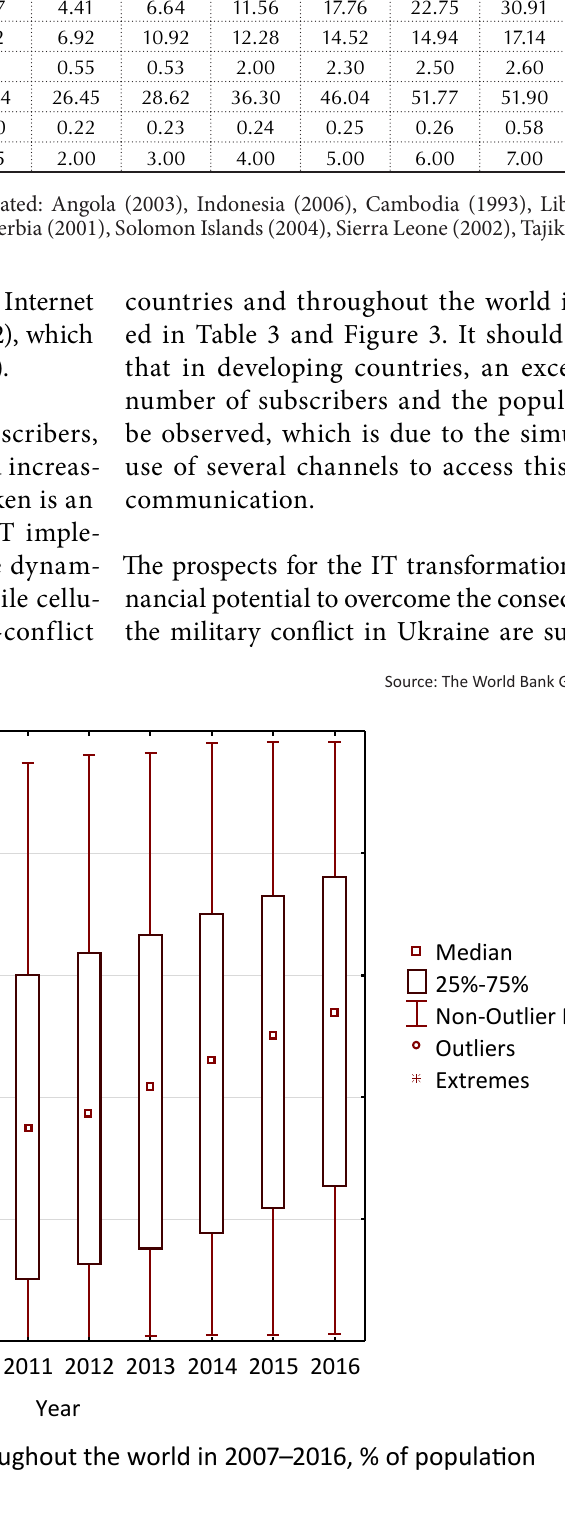
Figure 2. Internet users throughout the world in 2007–2016, % of population